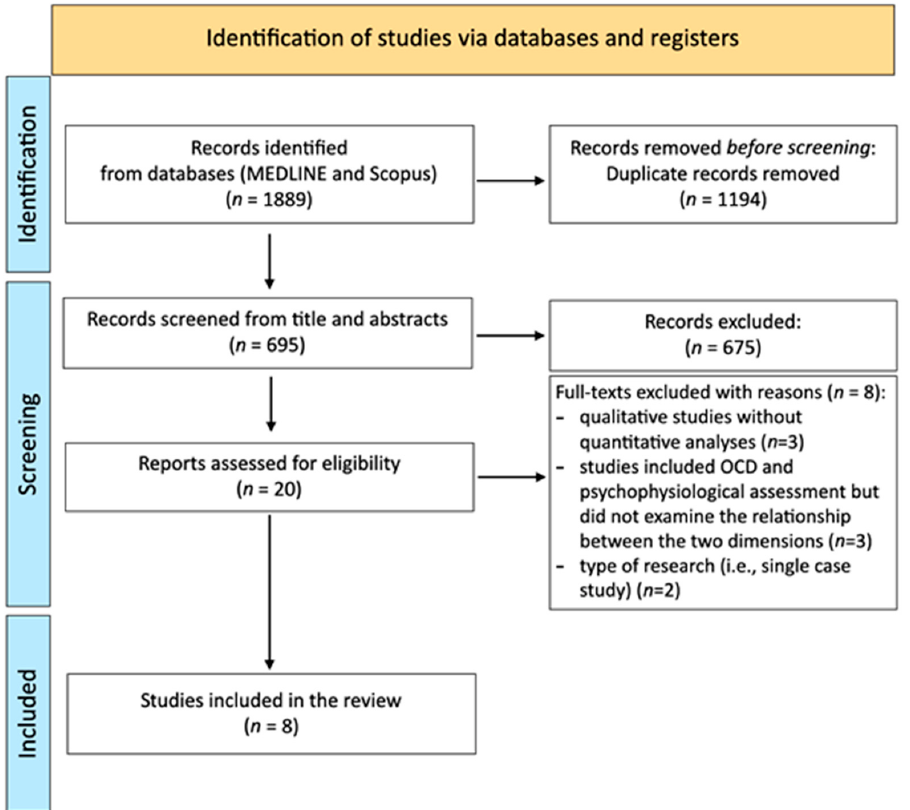
Figure 1. PRISMA flow diagram showing the selection of primary studies.